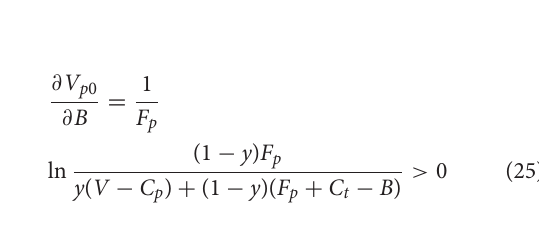
FIGURE 4 | Phase diagram of third-party testing agencies strategic choice. Figure is the phase diagram that shows the evolutionary trend of third-party testing agencies’ strategy obtained by calculating the response function of the probability of third-party testing agencies choosing the “non-collusion”